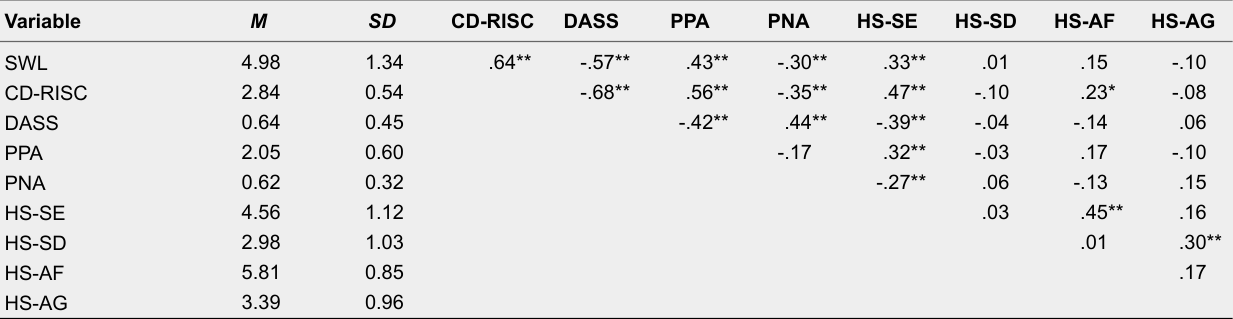
Summary Statistics and Bivariate